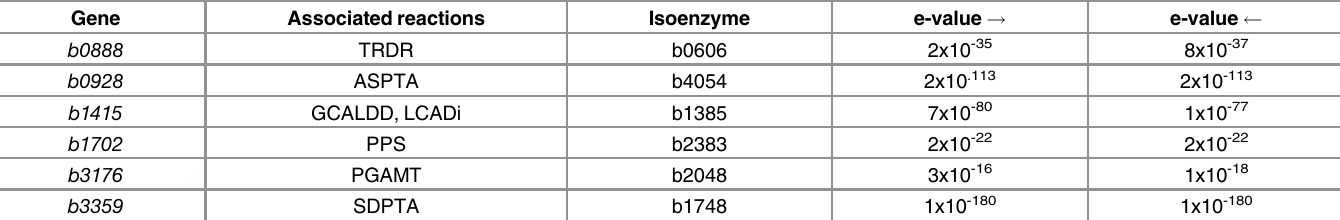
Table 4. Isoenzymes that resolved FNp.